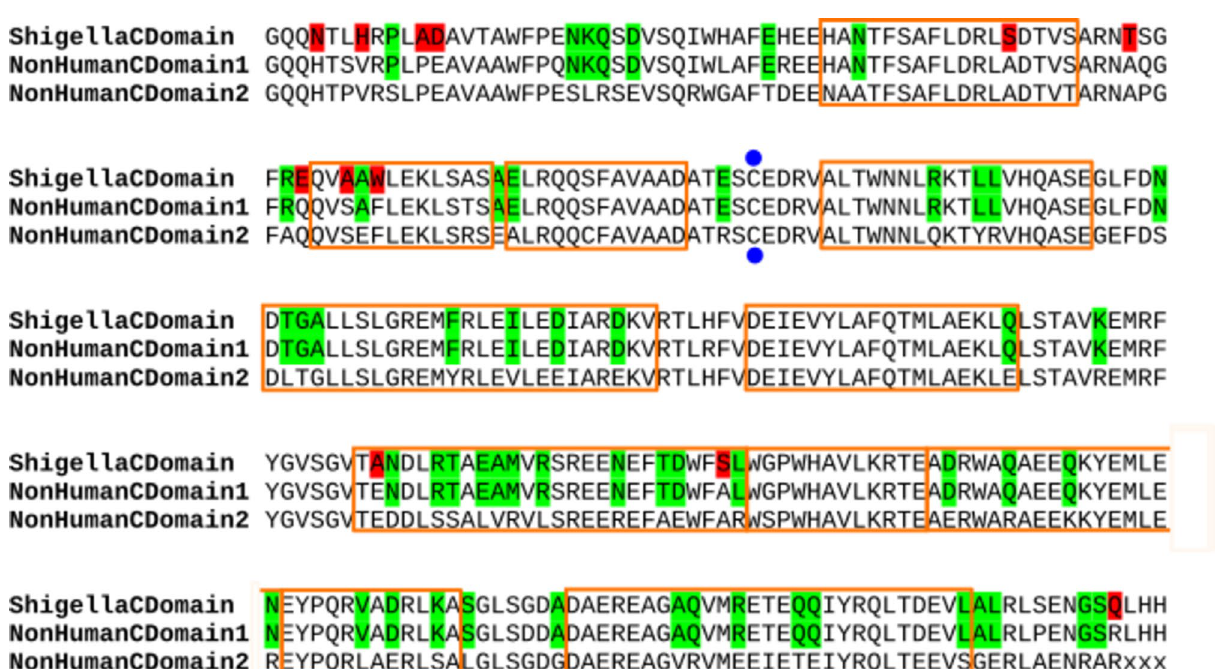
Figure 6. Alignment of the IpaH C-terminal domains from Shigella spp. and Escherichia marmotae . Consensus sequences are shown. The active site is marked in blue dots, alpha-helices are shown by orange frames. The differences between Shigella and both E. marmotae proteins are marked in red, the differences between two types of the C-terminal domains in E. marmotae are marked in